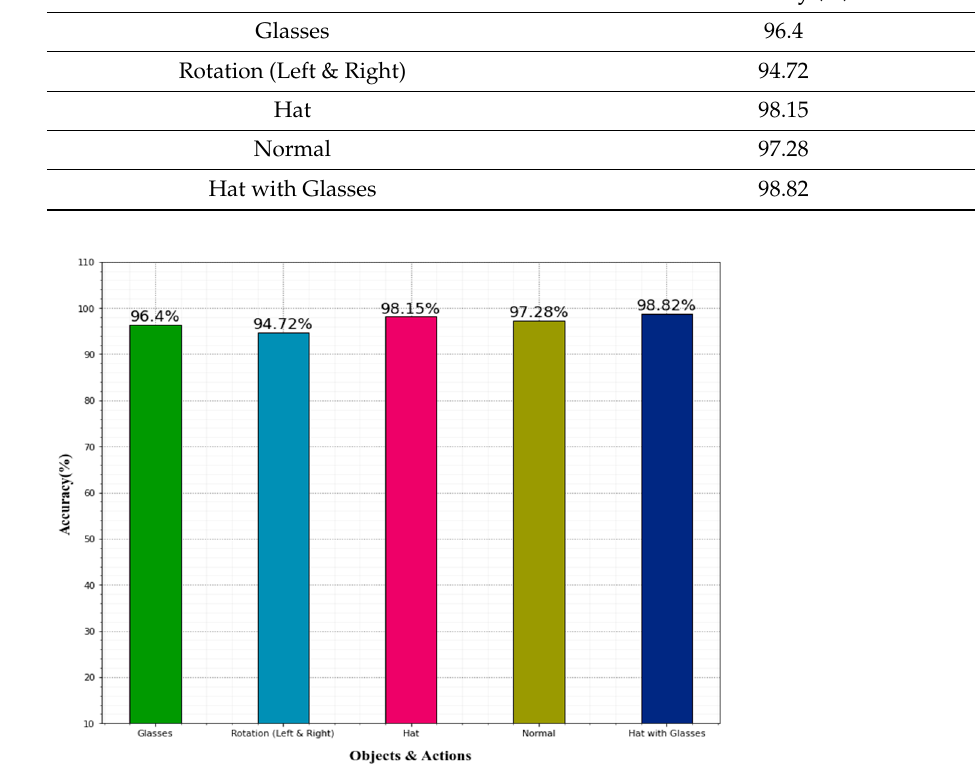
Table 6. Comparisons of various human face emotions accuracy.